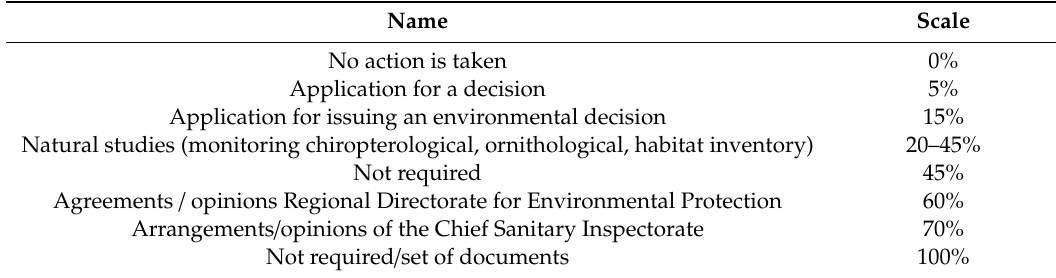
Table 7. Percentage scale of progress assessment in the procedure of obtaining a decision on the environmental conditions for consent to implement the